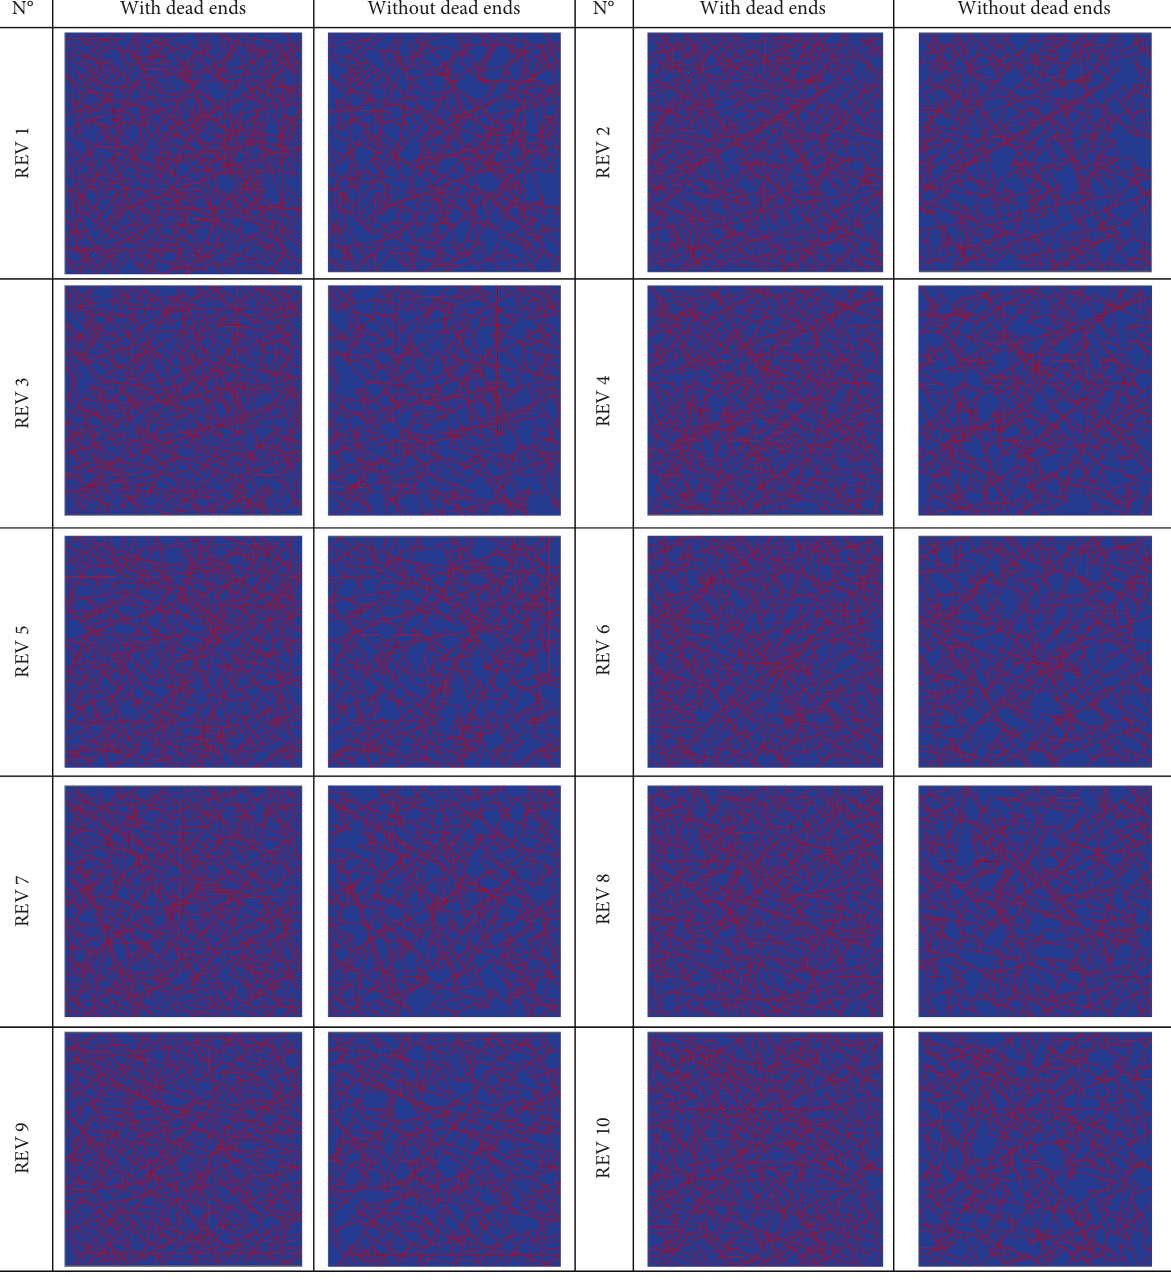
Figure 15: Ten realizations of the REV with 5m size of the Sellafield fractured rock by considering or not the dead-end